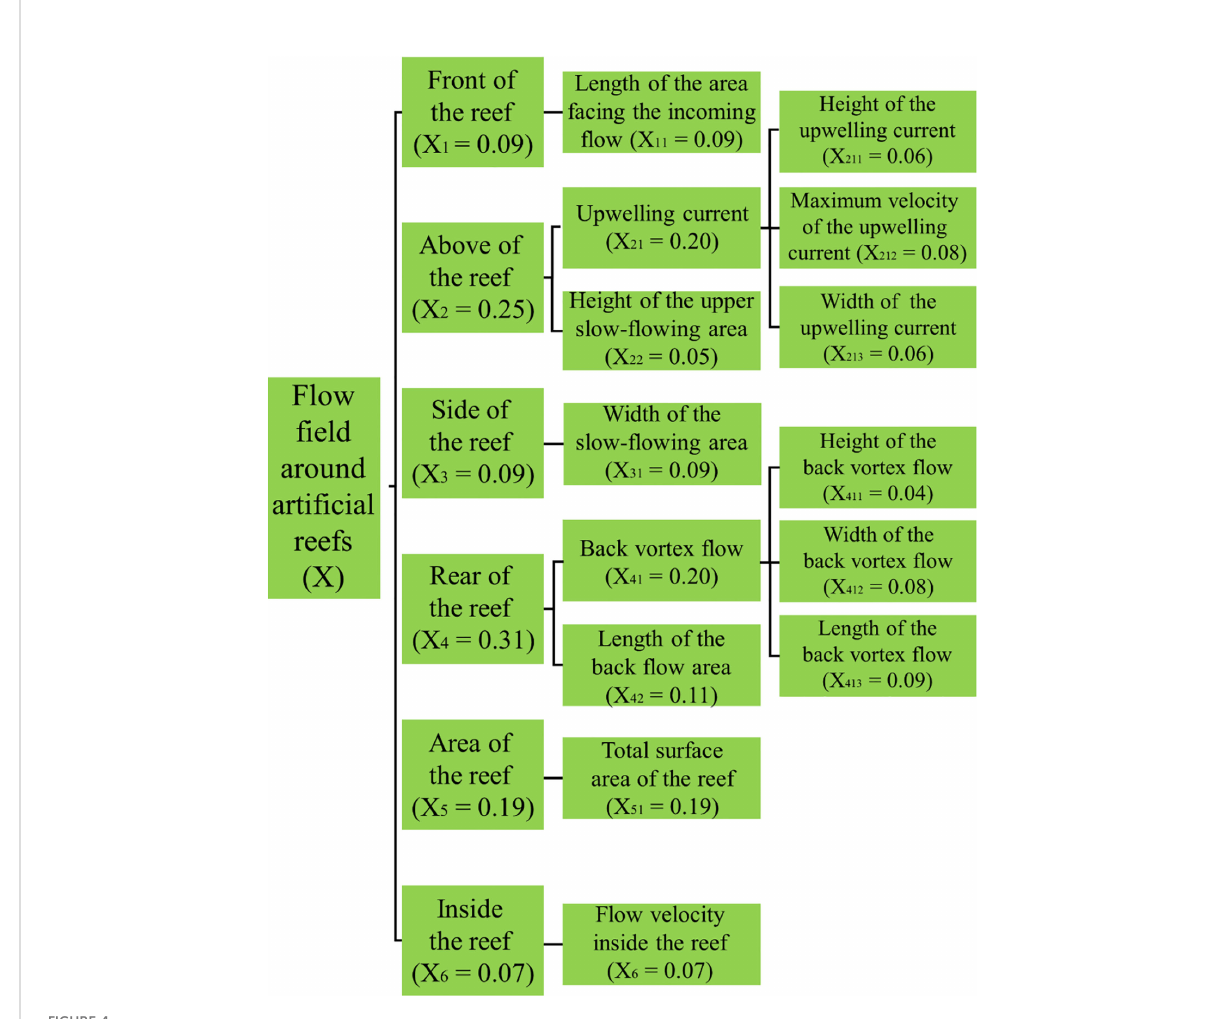
FIGURE 4 Evaluation model of the fl ow fi eld effect of ARs and the weights of evaluation indices in the